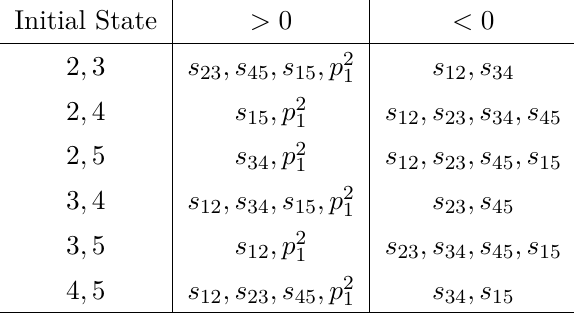
Table 1. Signs of the Mandelstam variables in ~s for the production of a massive vector boson (of momentum p ) in association with two jets in QCD. We consider the channels corresponding to any 1 pair of massless momenta in the initial